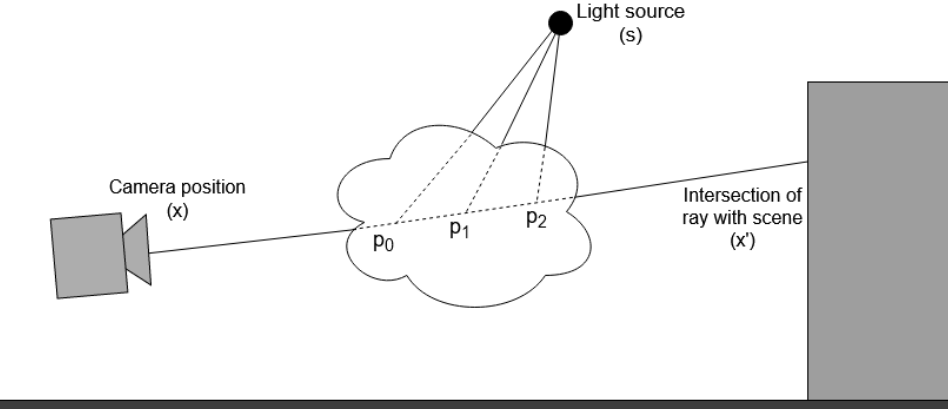
Figure 6. The volumetric rendering of the gas plume is based on taking concentration samples at several points along the view ray to compute the optical depth, and with it the transmittance of the gas puff. Additional rays are cast towards the light source at each sampling point to simulate the scattering of light towards the